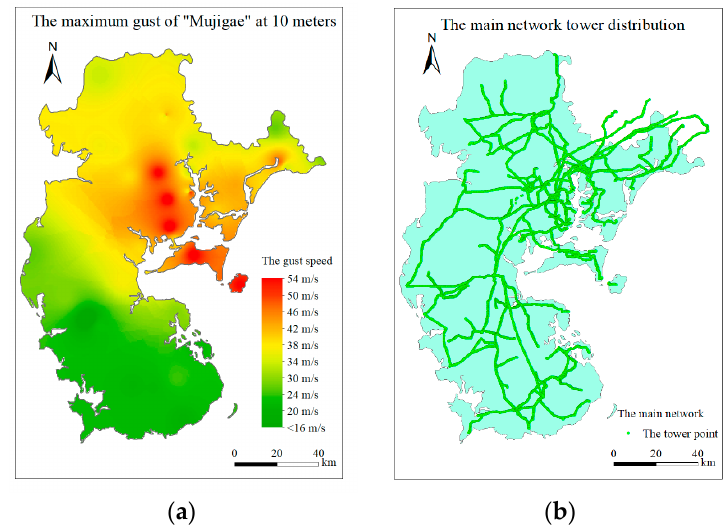
Figure 7. Distribution of maximum gust and main network tower. ( a ) The maximum gust of ‘Mujigae’ at 10 m. ( b ) The main network tower distribution.